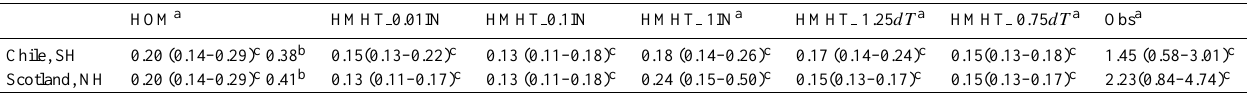
Table 4. Comparison of measured ice crystal number concentration (“Obs”) during the INCA campaign (Gayet et al., 2004) over the SH (Punta Arenas, Chile, in March/April) and over the NH (Prestwick, Scotland, in September/October) with those simulated from the prognostic ice crystal equations in the model (unit: #/cm 3 ).